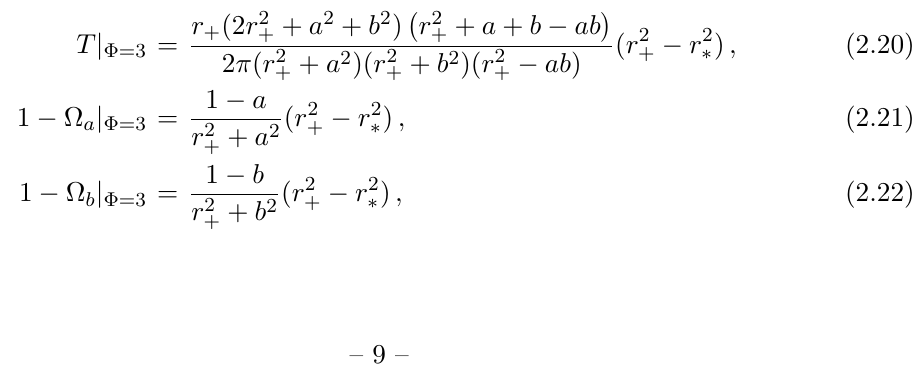
Figure 3 . Gibbs’ free energy G as function of the temperature T . The electric potential Φ = 1 . 5 is in the range 0 < Φ < 3 and the angular velocities increase from right to left as Ω 0 , 0 . 5 , 0 . 75 , 0 . 95 . For a given Ω Φ = 0 (compare with figure